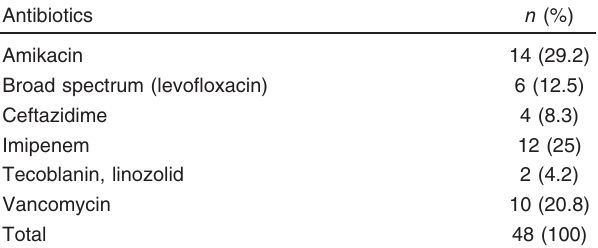
Table 12 Duration of used antibiotics for ventilator-associated pneumonia, duration of mechanical ventilation, and duration of stay in ICU